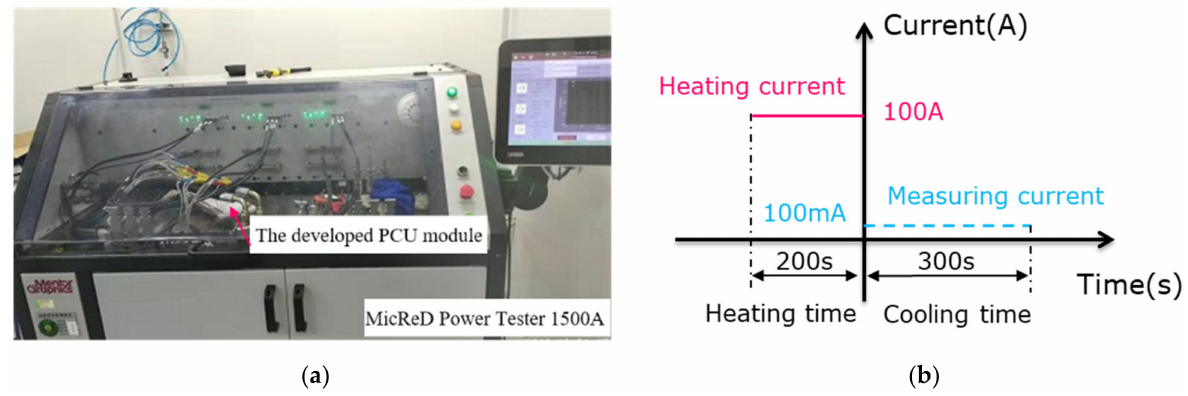
Figure 3. Experiment platform for testing the resistance and capacitance (RC) characteristics of the PCU module: ( a ) testing equipment and ( b ) testing